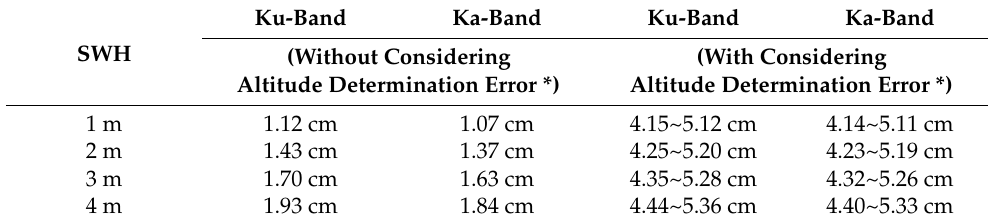
Table 2. 1 Hz theoretical height measurement precision of airborne data.